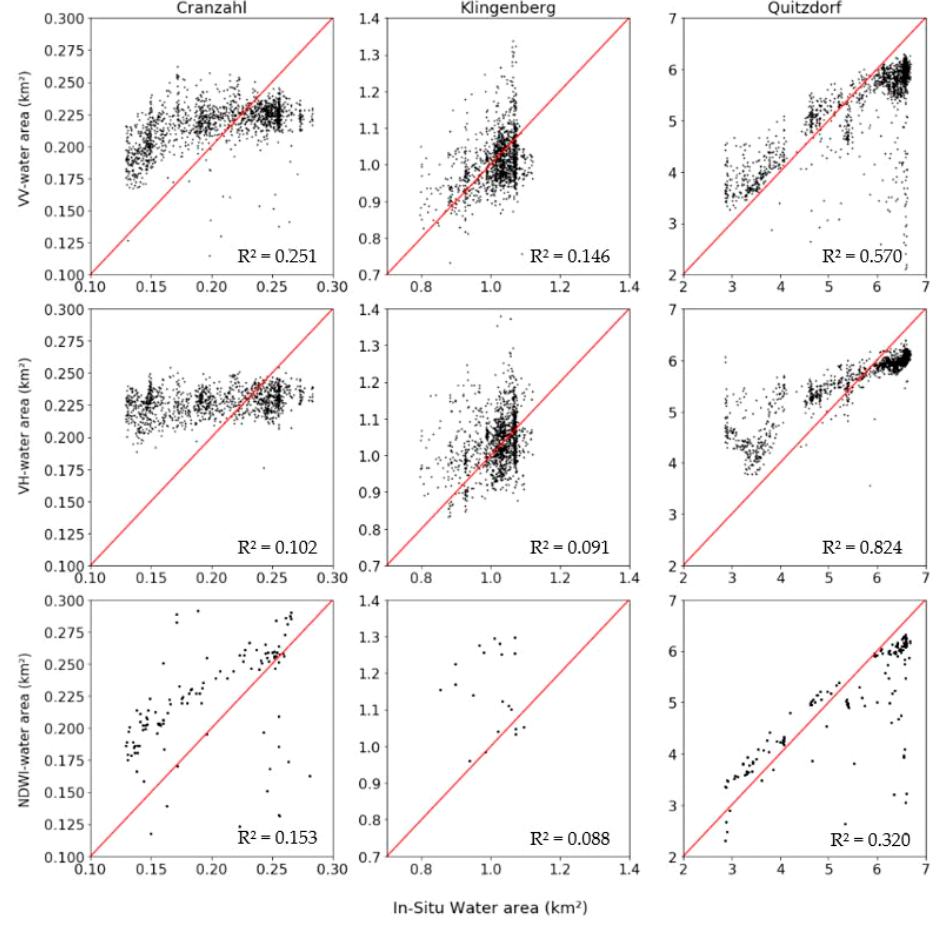
Figure 6. WMA-measured water area (km 2 ) in VV and VH polarization and by the NDWI compared to the in situ water area (km 2 ) for the period from 1 January 2016 to 31 December 2021. The red line marks the coincidence between the measured value and the in situ value.